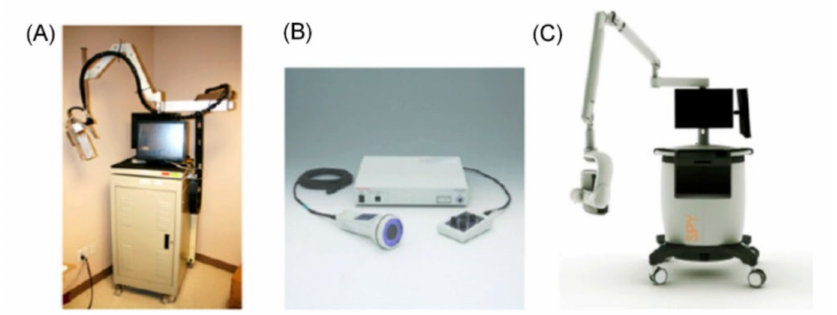
Figure 1. Commonly used near-infrared fluorescence imaging devices. ( A ) Frequency-domain photon migration (FDPM) imager, ( B ) Photodynamic eye, ( C ) SPY device. Adapted from Zhu B et al. Br. J. Radiol. 2015 Jan;88(1045):20140547